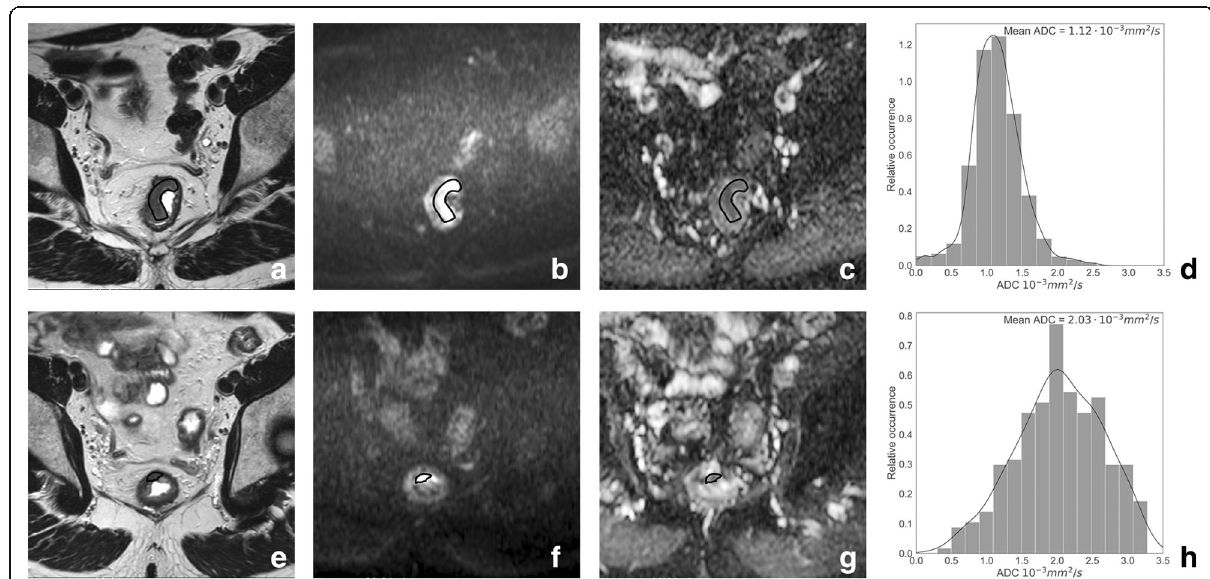
Fig. 12 Methods of DWI response evaluation. T2-weighted MRI ( a , e ), b1000 DWI ( b , f ), ADC map ( c , g ), and histograms of ADC values ( d , h ) of a patient with a mid-rectal tumor pre- (upper row) and post-CRT (bottom row). The images illustrate different ways DWI can be used to quantitatively assess response: pre-CRT the DWI tumor volume was 11.4 cm 3 with a corresponding mean ADC of 1.12 ∙ 10 − 3 mm 2 /s. Post-CRT the DWI tumor volume decreased to 0.32 cm 3 , while the ADC value increased to 2.03 ∙ 10 − 3 mm 2 /s. The histograms show that the distribution of ADC values within the tumor shifted towards more high ADC values after CRT, indicating a good response. At histopathology, a small ypT2 tumor remnant with predominant fibrosis (Mandard tumor regression grade of 2) was